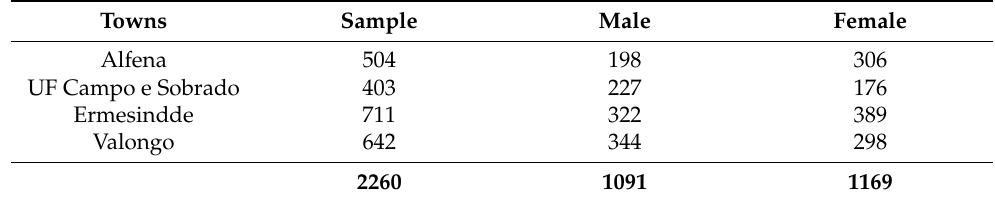
Table 1. Characterization of the sample.